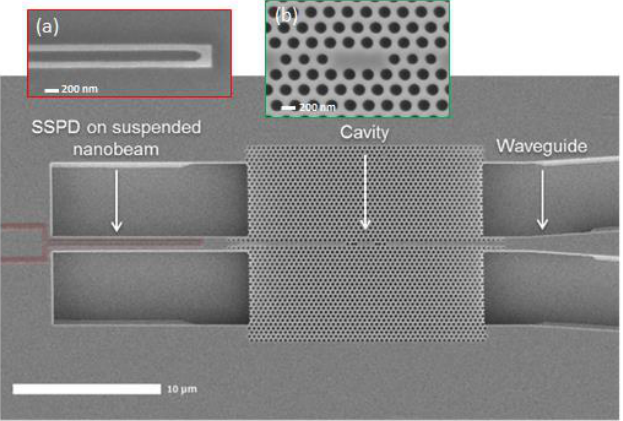
Figure 2. Scanning electron microscopy (SEM) picture of the full QPIC. Zoomed pictures of SSPD ( a ) and PhCC ( b ).